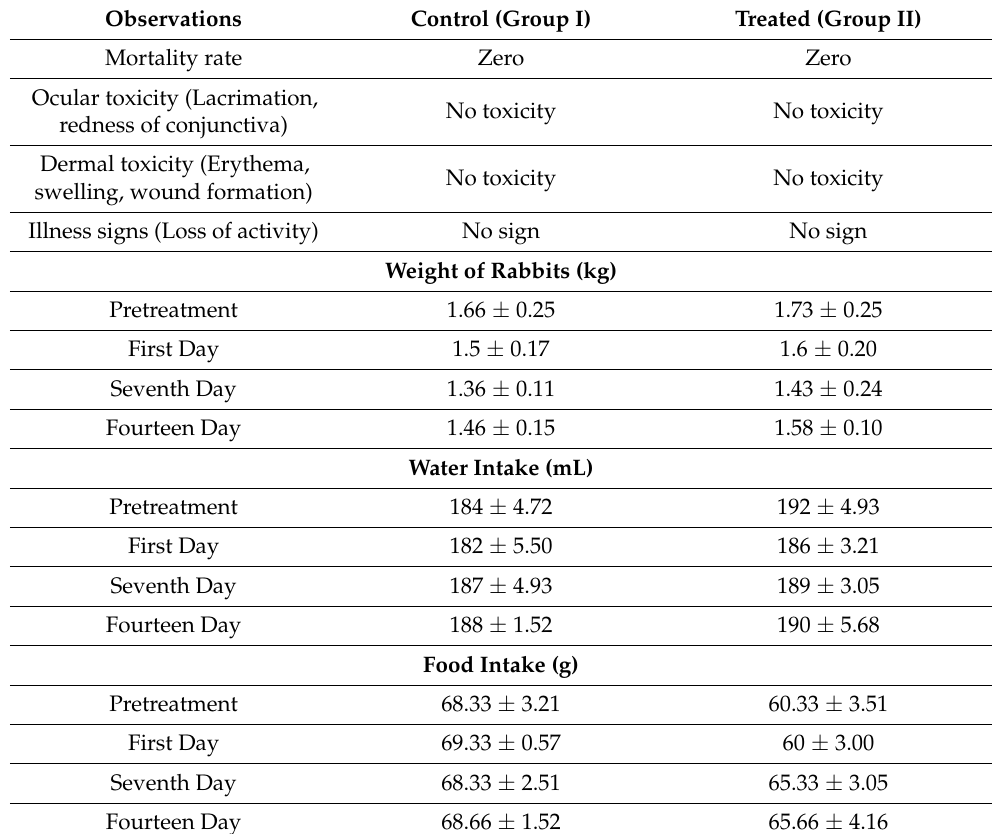
Table 5. Clinical examination of control and treated groups ( n =